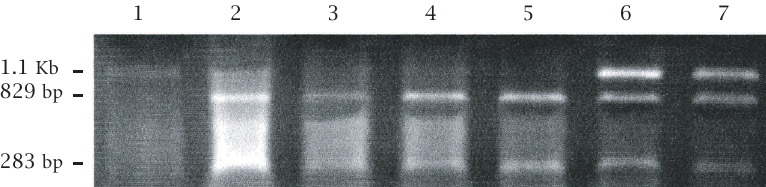
Figure 2: Polymorphism of the Xba1 site in a 1.1Kb fragment generated from the 5 (cid:2) region of the human ITGB2 (CD18) gene. 1 . 2% agarose gel electrophoresis of amplified DNA from Tunisian individuals following Xba1 restriction enzyme digestion. Lane 1: individual homozygous for allele A1 (absence of the polymorphic Xba1 site). Lanes 2, 3, 4, and 5: individuals homozygous for allele A2 (829 and 283bp). Lanes 6 and 7: individuals heterozygous